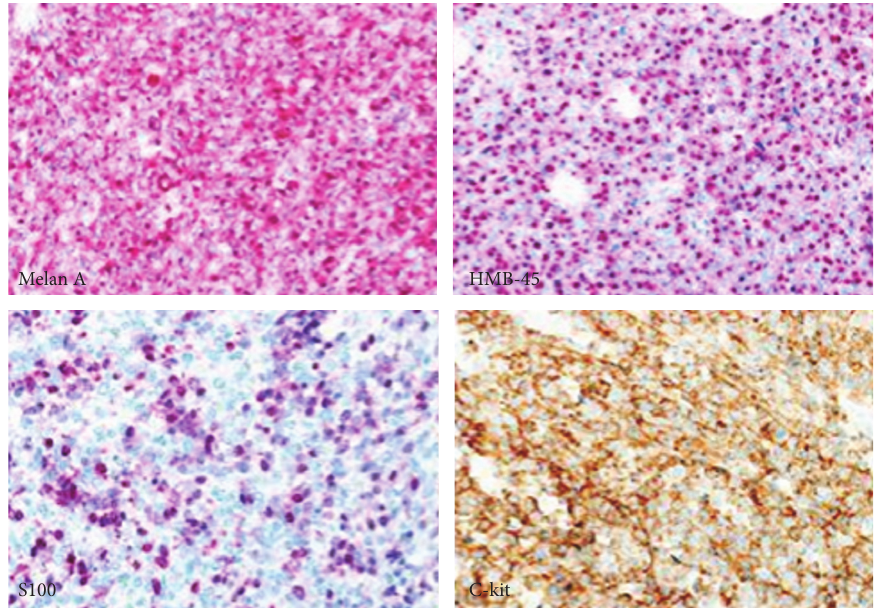
Figure 4: Microscopic histopathology of tumour with Melan A, HMB-45, and C-kit staining ( × 200